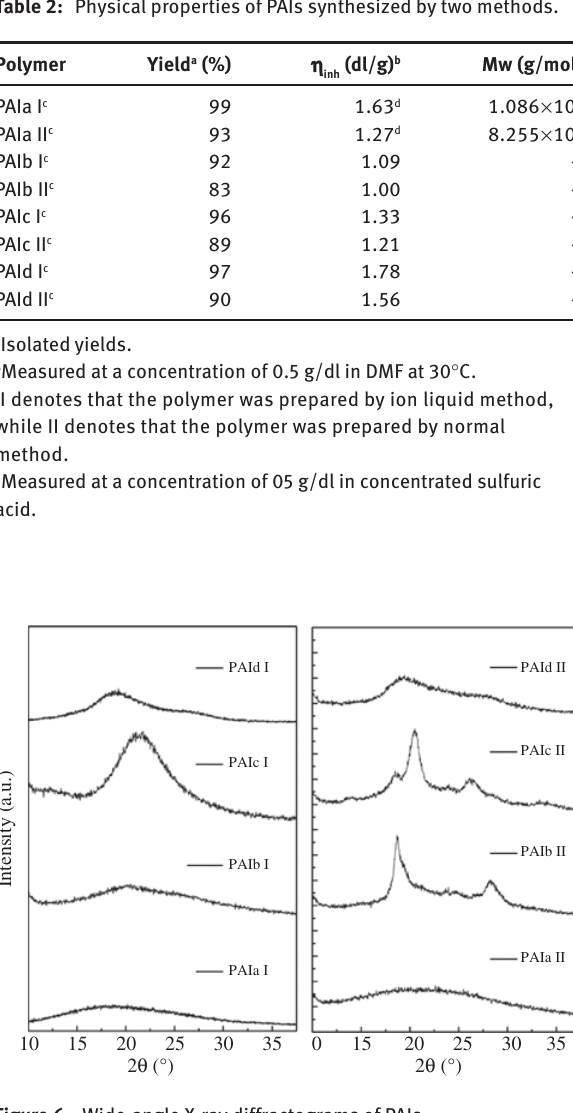
Figure 6: Wide-angle X-ray diffractograms of PAIs.